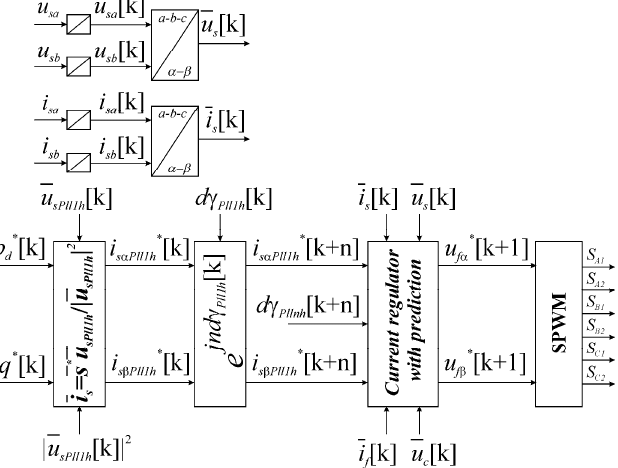
Figure 7. Block diagram of the grid converter control algorithm.